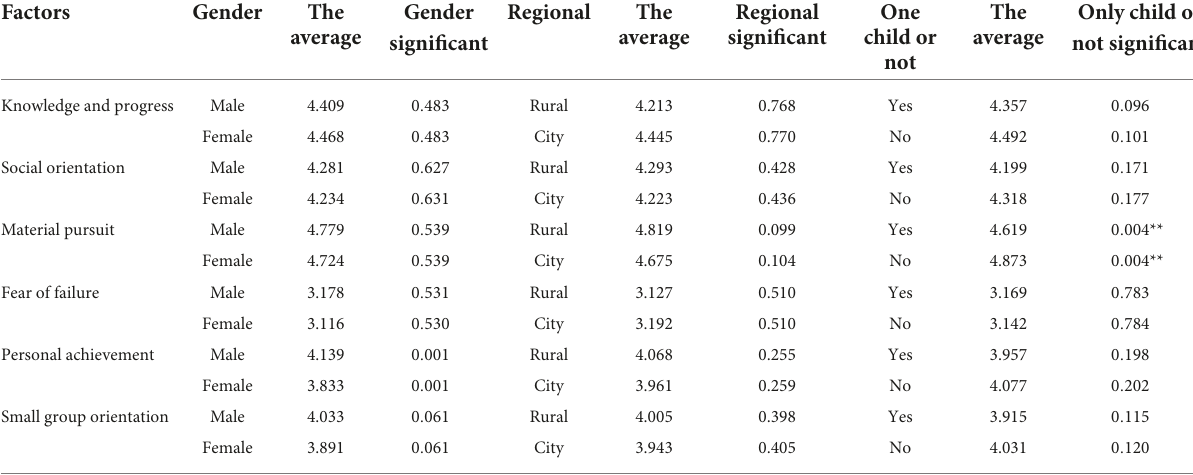
TABLE 2 Significance of learning motivation in gender, region, and only child or